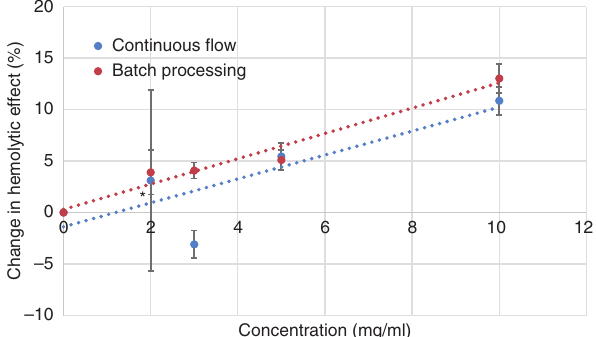
Figure 5: Hemolytic effect for continuous flow and batch processing with increase in nanoparticle concentration. *Significant difference between two samples at same concentration (p-value < 0.05). Data are presented as means ± SD, n =